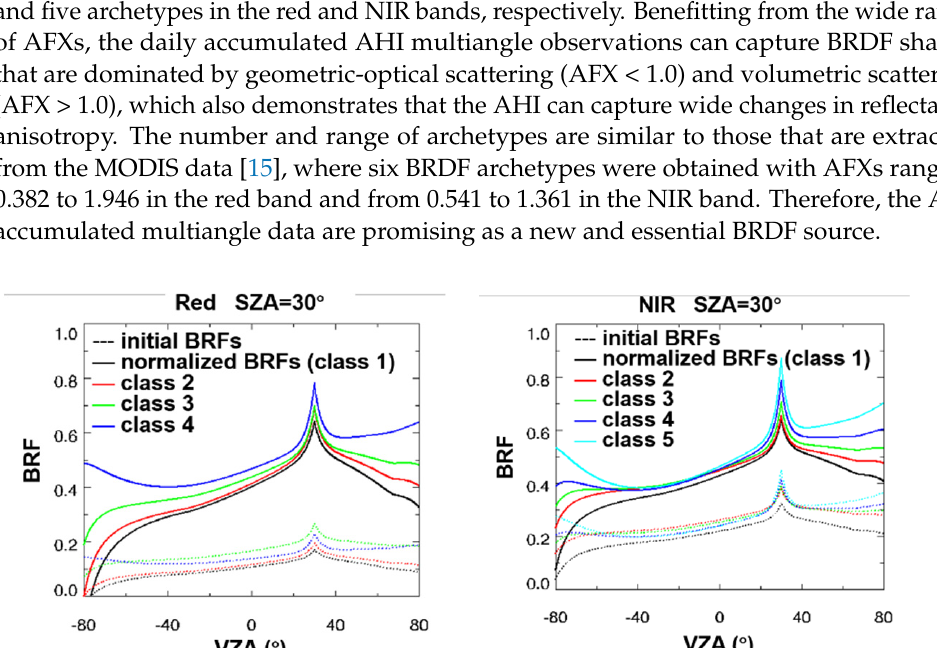
Figure 10. Comparison of AFXs that were retrieved from the accumulated observations of POLDER, MODIS CMG, and AHI during a day and half a month. ( a ) refers to the variance ranges of AFX that were retrieved from accumulated multiangle observations of the three sensors at different time spans. ( b ) refers to comparisons of AFX that were retrieved from half-month (black circle) and daily (grey dot) AHI data with those from half-month MODIS data in the red band, and ( c ) is similar to ( b ) but in the NIR band. ( d , e ) refers to comparisons of AFX that were retrieved from AHI data be- tween the half-month scale and daily scale in the red and NIR bands, respectively.